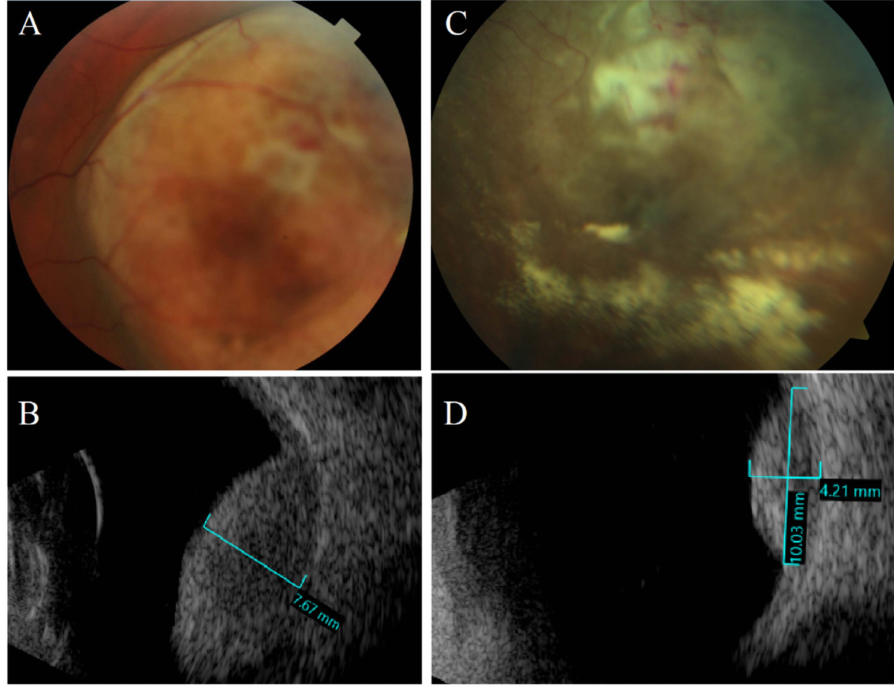
Figure 4. Left eye with amelanotic choroidal melanoma ( A , B ) showed a 7.7 mm thick dome shape tumor with moderate low internal reflectivity. Six months after treatment with I-125 radioactive plaque, the tumor showed regression clinically ( C ), and thickness decreased to 4.2 mm ( D ).